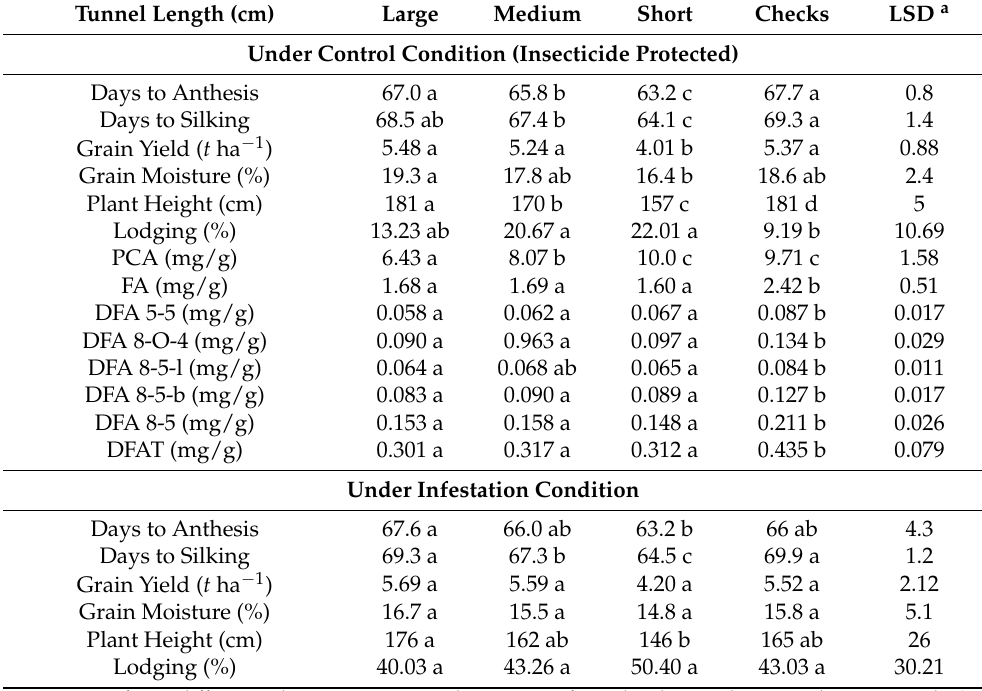
Table 1. Contrast analysis for the t large, short and medium tunnel length groups and checks of RILs classified according to resistance to corn borer. Means for agronomic traits and hydroxycinnamic acids with significant differences among groups are